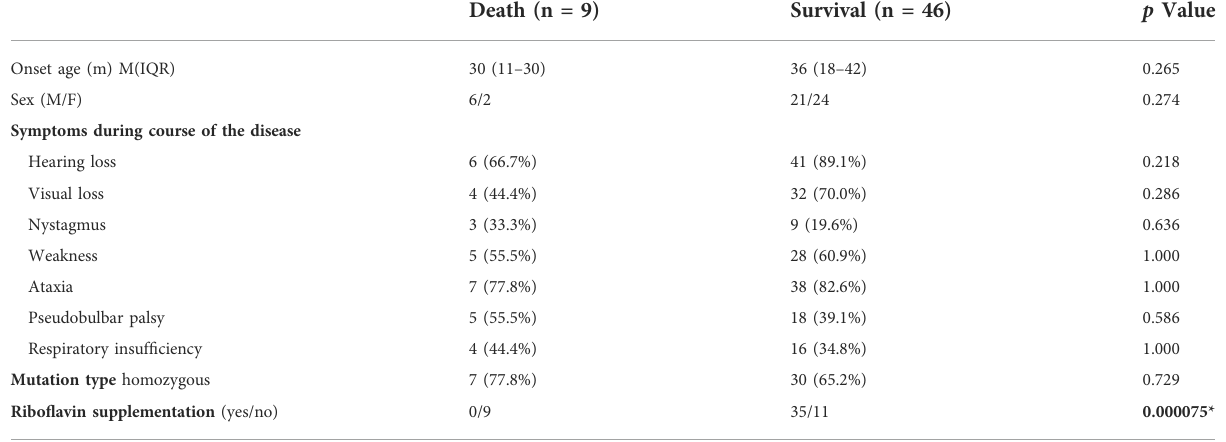
TABLE 5 Association of clinical features with